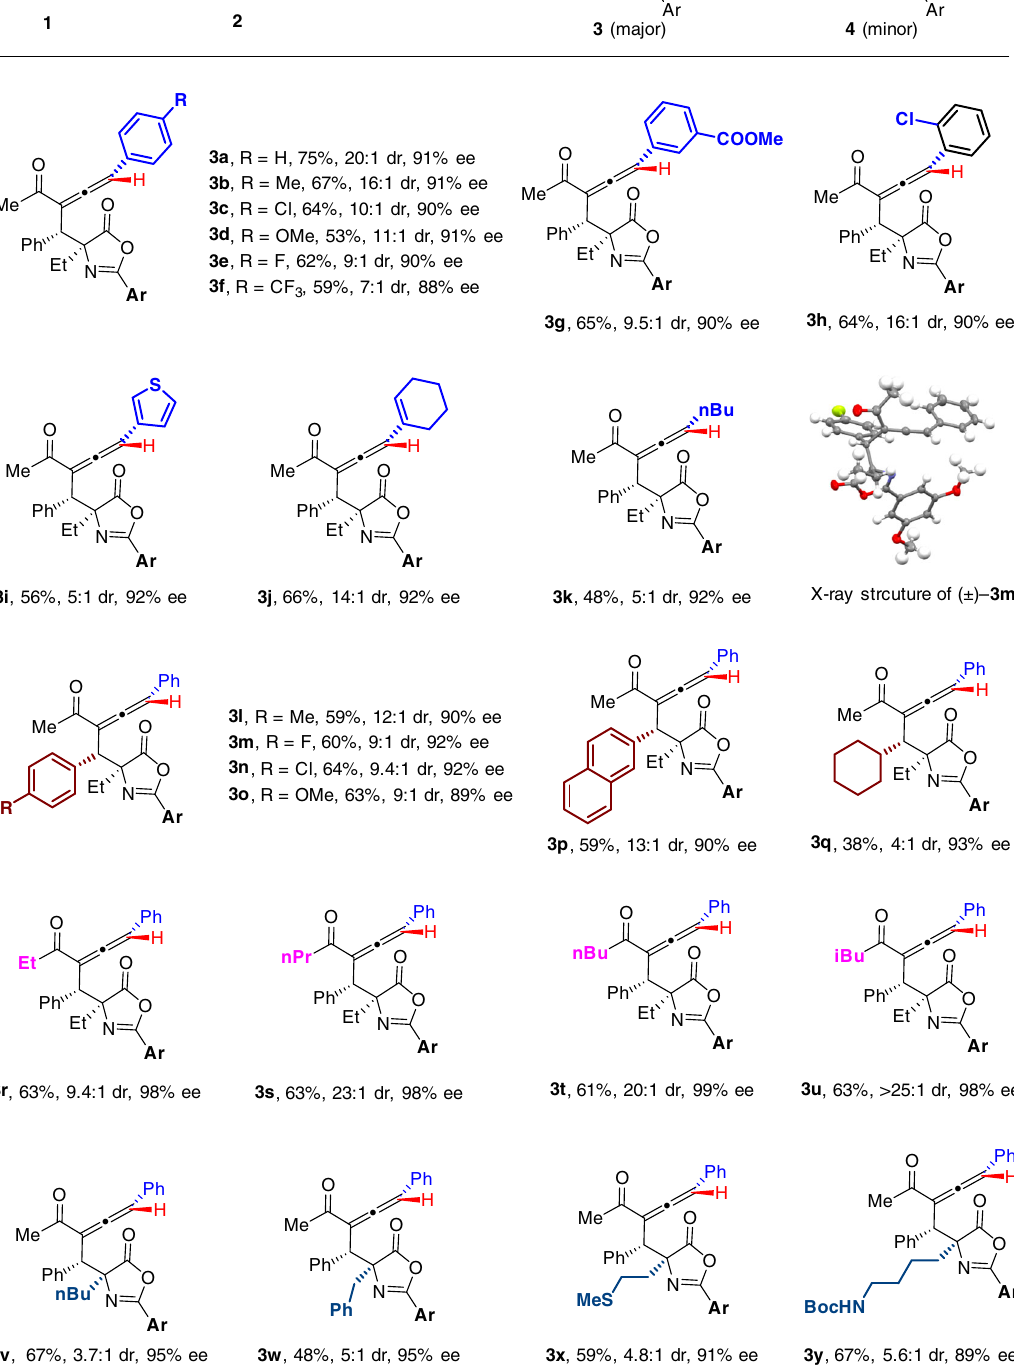
Fig. 2 Scope for asymmetric synthesis of trisubstituted allenes 3 catalyzed by CPA catalyst (S)-B2. Unless otherwise noted, reactions were performed with 1 (0.15 mmol), 2 (0.1 mmol), ( S )- B2 catalyst (0.01 mmol) and 3 Å MS (100 mg) in CCl 4 (0.5 mL) at room temperature for 24 h. Yields were isolated yields of allenes 3 . Dr values were determined by crude 1 H NMR analysis. Ee values were determined by HPLC analysis on a chiral stationary phase. Ar =